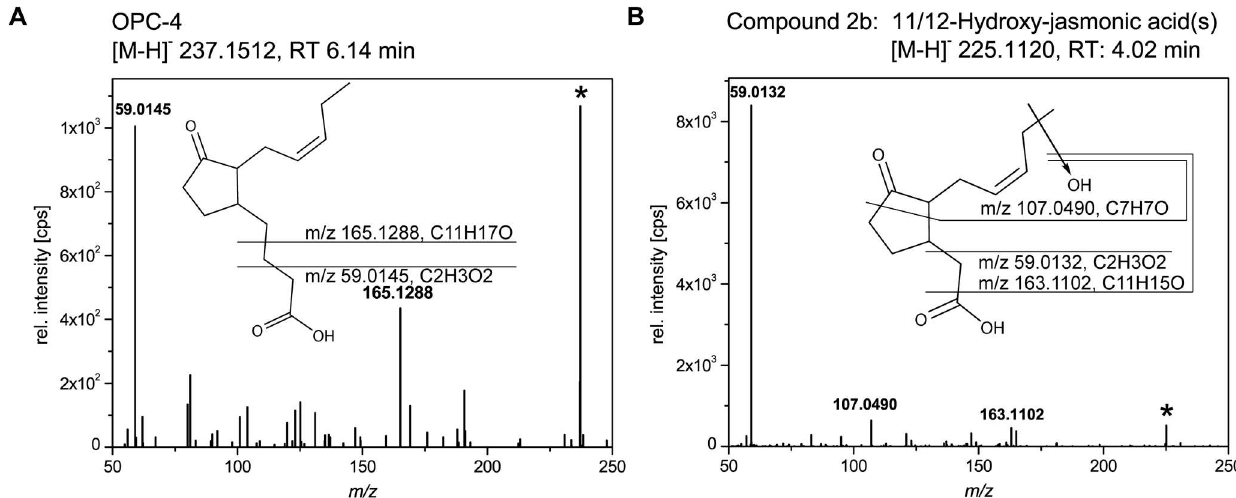
Fig 1. UHPLC-ESI-QTOF-MS analysis of OPC-4 and 11/12-hydroxy-JA formed by L . theobromae strain 2334. The fungus was cultivated in medium supplemented with KNO 3 for 9 days (d). After extraction compoundsof the culture filtrate were analyzedvia UHPLC-ESI-QTOF-MS. Shown are high resolution MS/MS spectra (negative ionizationmode; collisionenergy 10 eV) of ( A ) OPC-4 ([M-H] - 237.1512,RT 6.14 min) and ( B ) 11/12-hydroxy-JA ([M-H] - 225.1120,RT 4.02 min). Proposedfragmentation is shown as inset. Abbreviations: JA, jasmonicacid; OPC-4, 3-oxo-2-(pent-2-enyl)-cyclopentane-1-butanoic acid.